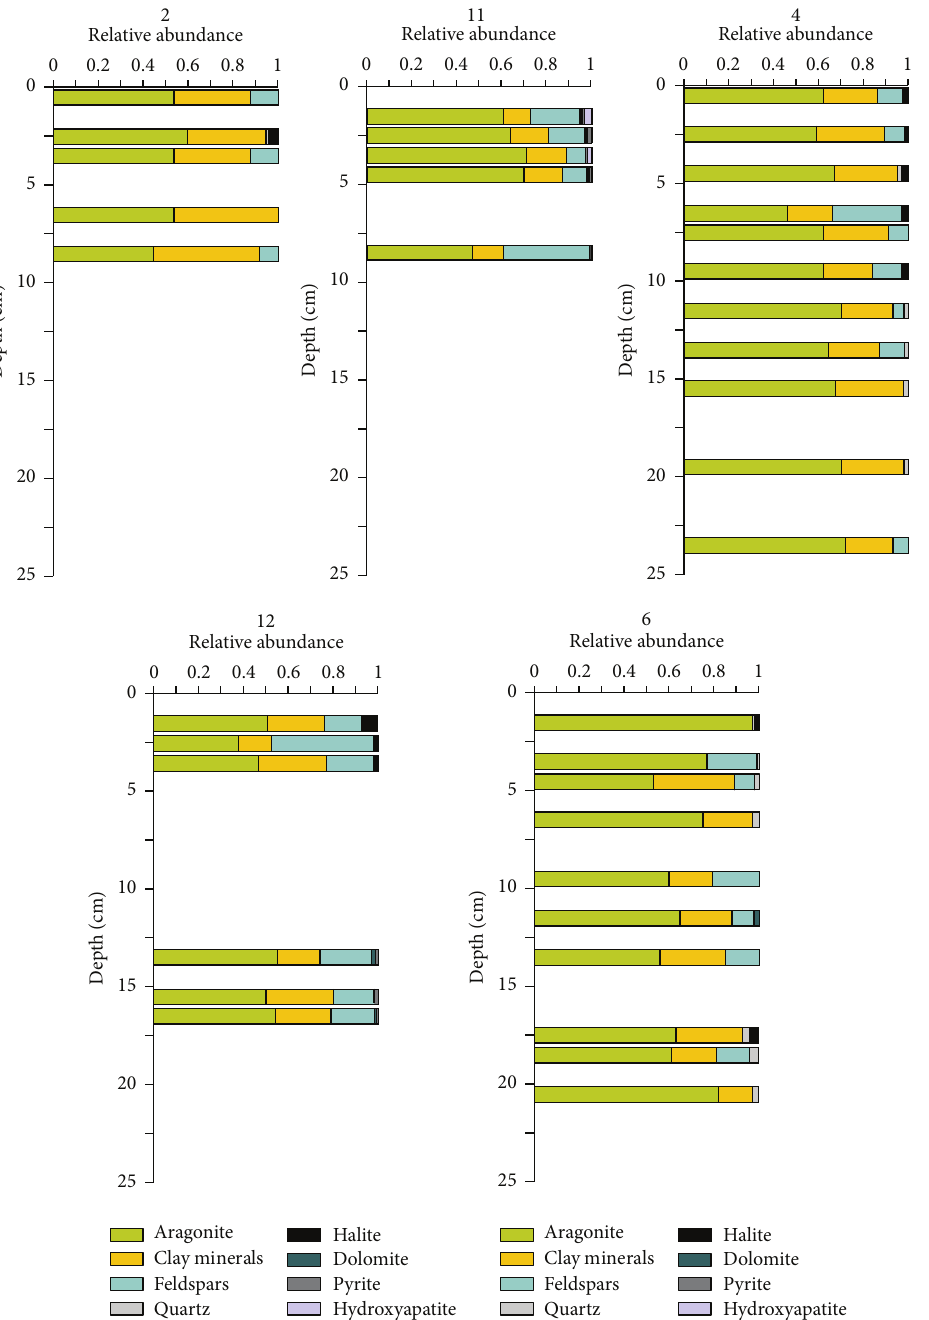
Figure 2: Relative abundance of the mineralogical phases of sediment